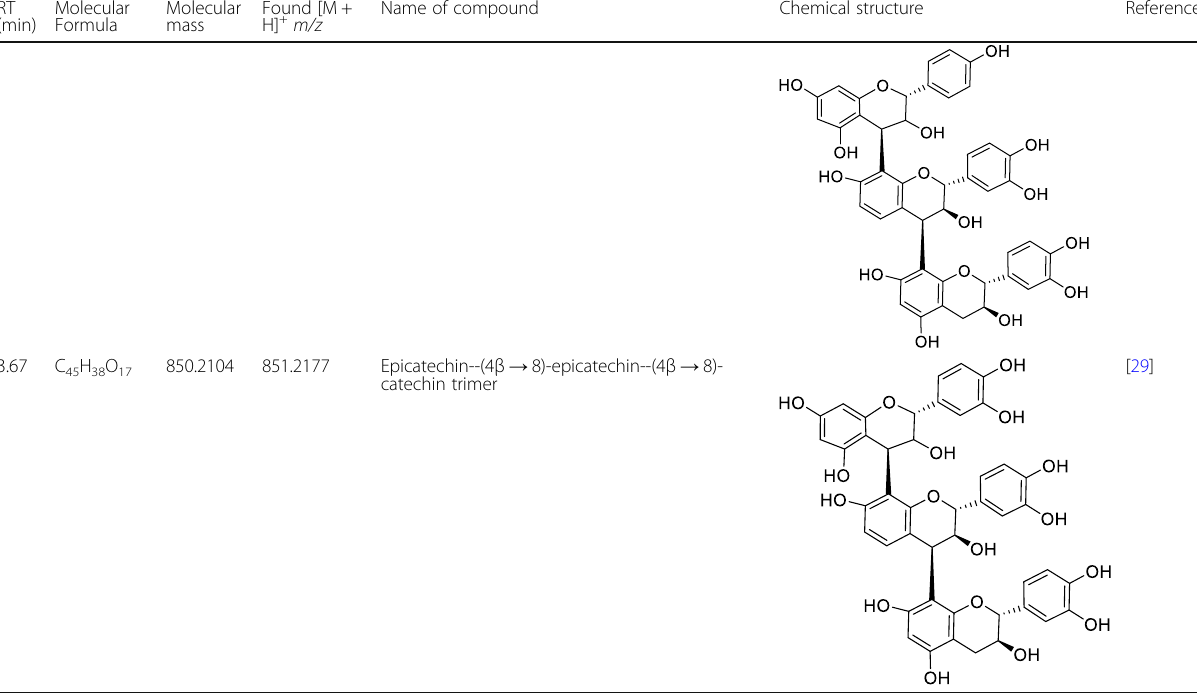
Table 2 Tentative identification of compounds detected from CGEEA-F5 – 8 by LC-MS/MS using on-line ChemSpider database (http://www.chemspider.com) and Reaxys database (https://www.reaxys.com) (Continued) RT Molecular Molecular Found [M + (min) Formula mass H] +